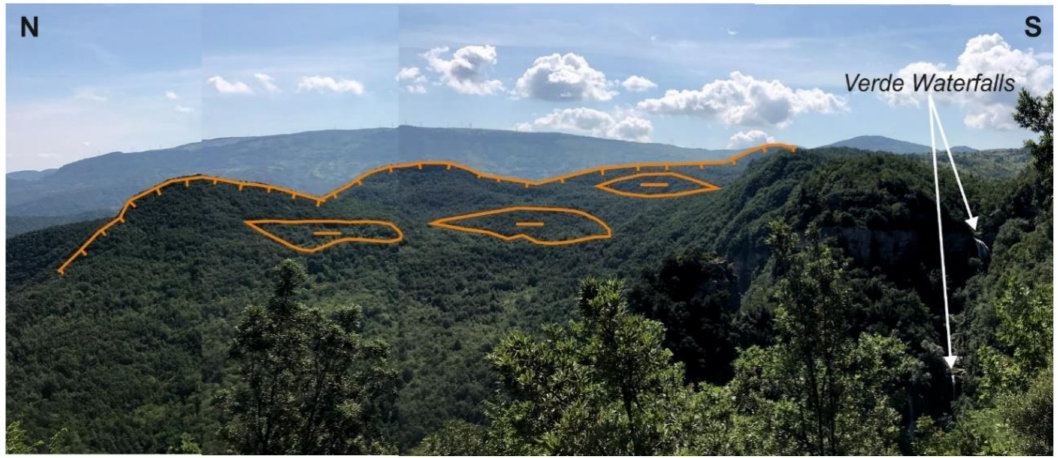
Figure 16. Broken doline near the Verde Waterfalls (780–580 m a.s.l.).